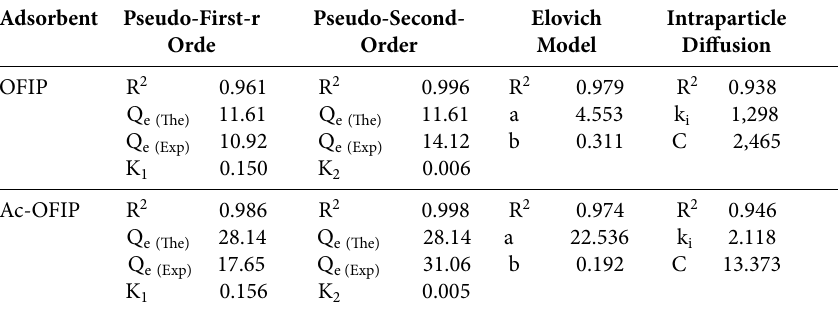
Table 4. Correlation coefficients R 2 and constant values of kinetics parameters of manganese adsorp- tion by OFIP and Ac-OFIP. Adsorbent Pseudo-First-r